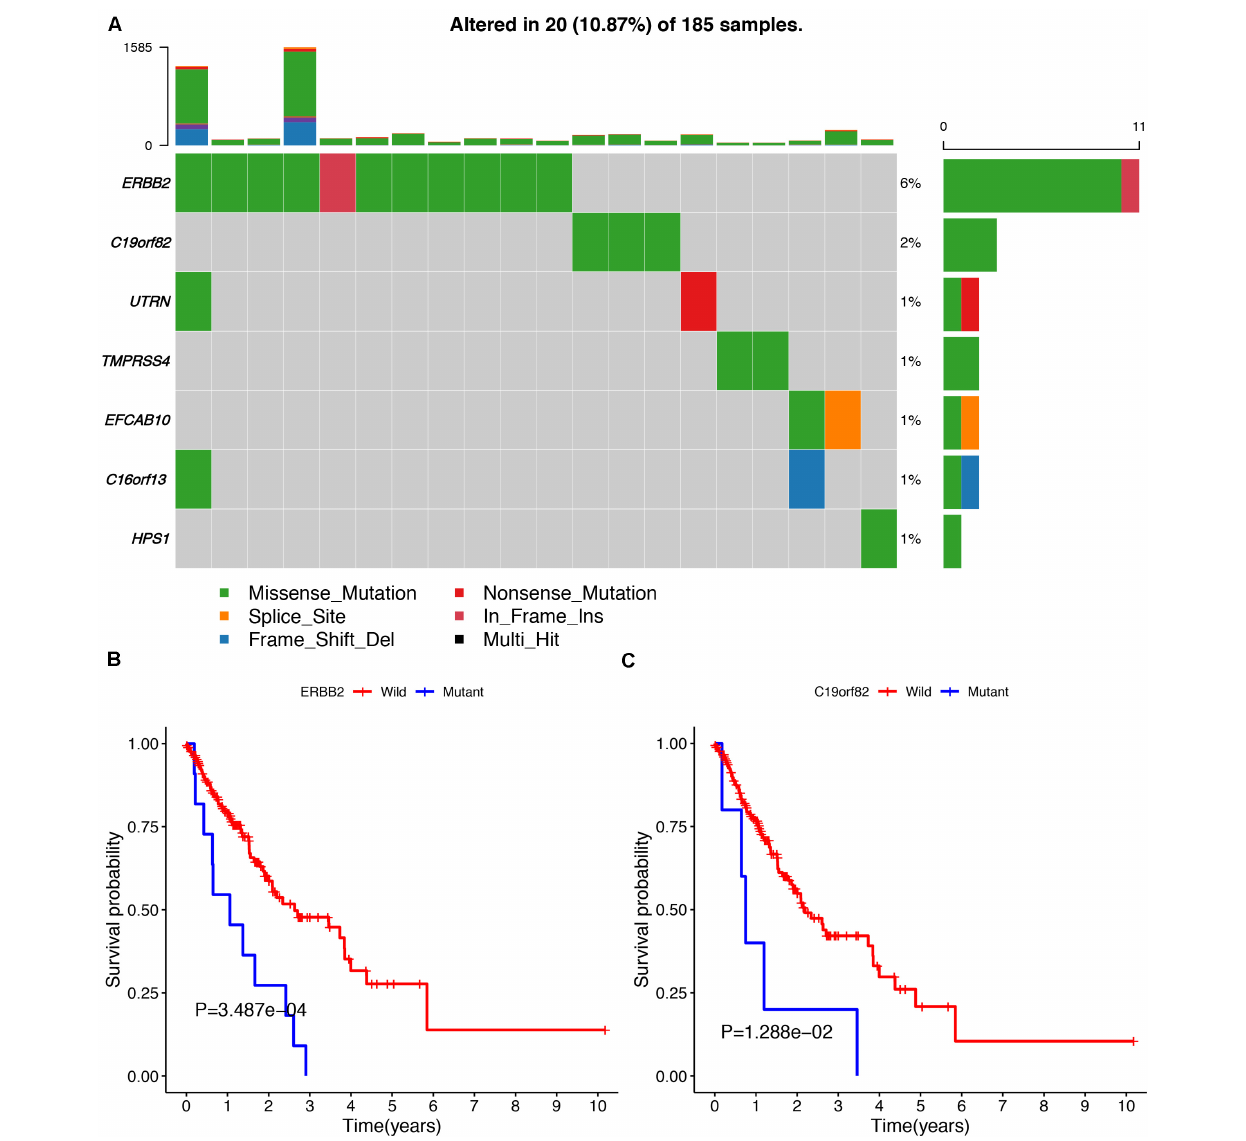
FIGURE 8 | The mutation profiling of parent genes in ESCA samples. (A) The waterfall plot of parent genes in ESCA cohort. (B,C) Kaplan-Meier survival curves of two different mutated genes (ERBB2 and